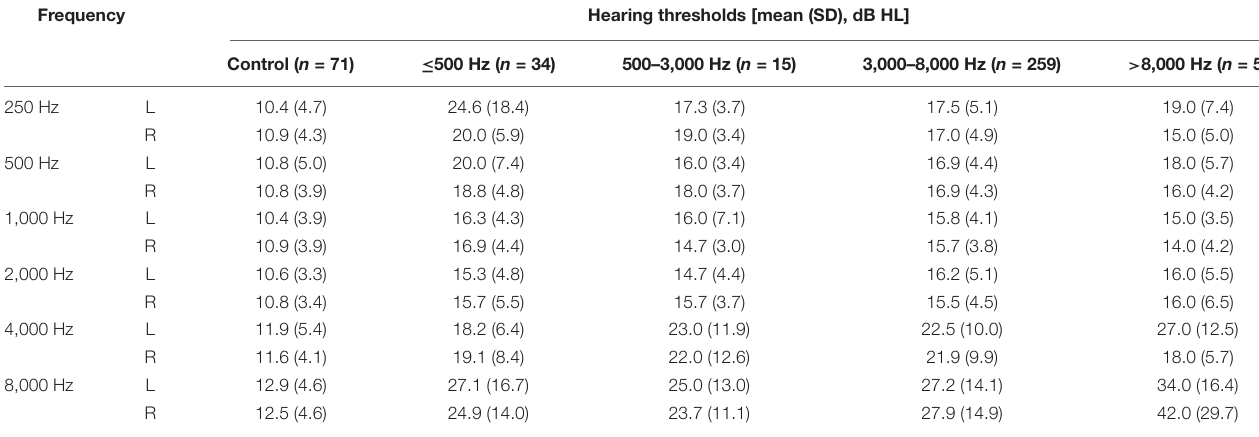
TABLE 2 | The average pure tone thresholds (mean) and the corresponding standard deviations (SD) in different subgroups with tinnitus and the control group without tinnitus.